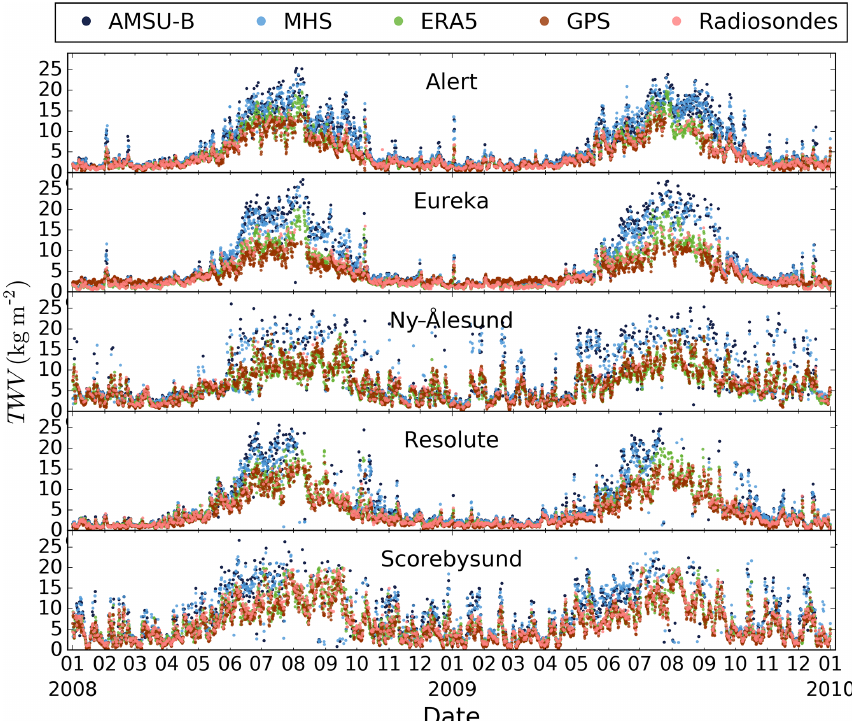
Figure 7. Time series of AMSU-B (dark blue), MHS (light blue), ERA5 (green), GPS (purple) and radiosonde (salmon) TWV retrievals during 2008 and 2009. Table 4. Parameters for linear regression for monthly MHS and AMSU-B intercomparison. Month R 2 Slope Intercept RMSD Bias Number of (kgm − 2 ) (kgm − 2 ) (kgm − 2 ) points January 0.90 0.85